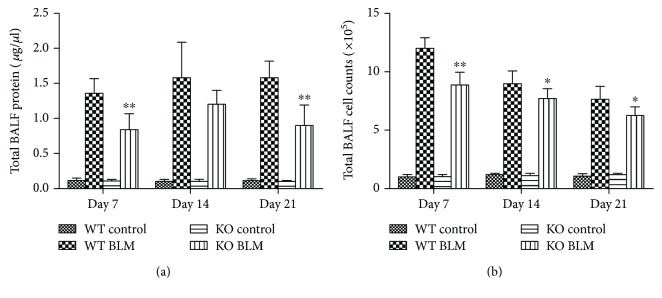
Effect of 5-HT on protein and inflammatory cell infiltrations in BALF induced by bleomycin in mice. Intratracheal instillation of bleomycin (BLM) hydrochloride was performed to induce pulmonary fibrosis in wild-type C57BL/6 (WT) and TPH1 knockout (KO) mice. The mice in the WT and KO control, WT BLM, and KO BLM groups were sacrificed on days 7, 14, and 21, and bronchoalveolar lavage fluids (BALF) were collected to determine the (a) total BALF proteins and (b) total BALF cell counts. All data were expressed as mean ± SD, n = 6. ∗P < 0.05 and ∗∗P < 0.01 versus the WT BLM group.